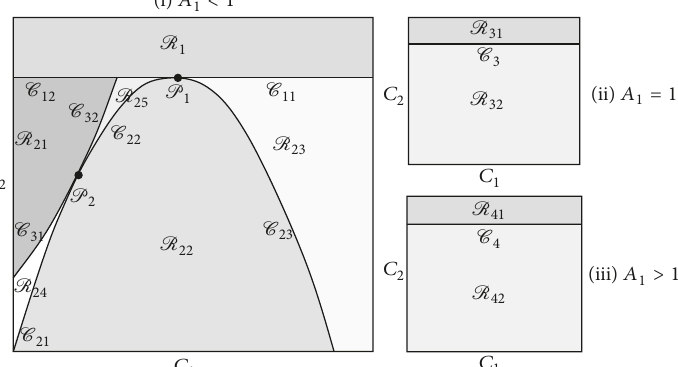
Figure 1:Parameter regionsin the (𝐶 1 , 𝐶 2 ) -plane. The curves C 21 , 𝐶 22 , and C 23 are defined as partof theparabola 𝐶 2 = 𝐶 1 (1−𝐴 1 −𝐴 2 𝐶 1 )/(1− 𝐴 ) 2 and the curves C 1